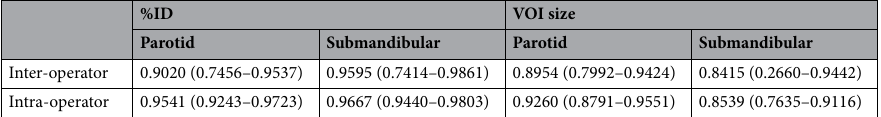
Table 1. ICCs for %ID by SPECT and VOI size by CT ( n = 30). Parentheses indicate the 95% confidence interval of the